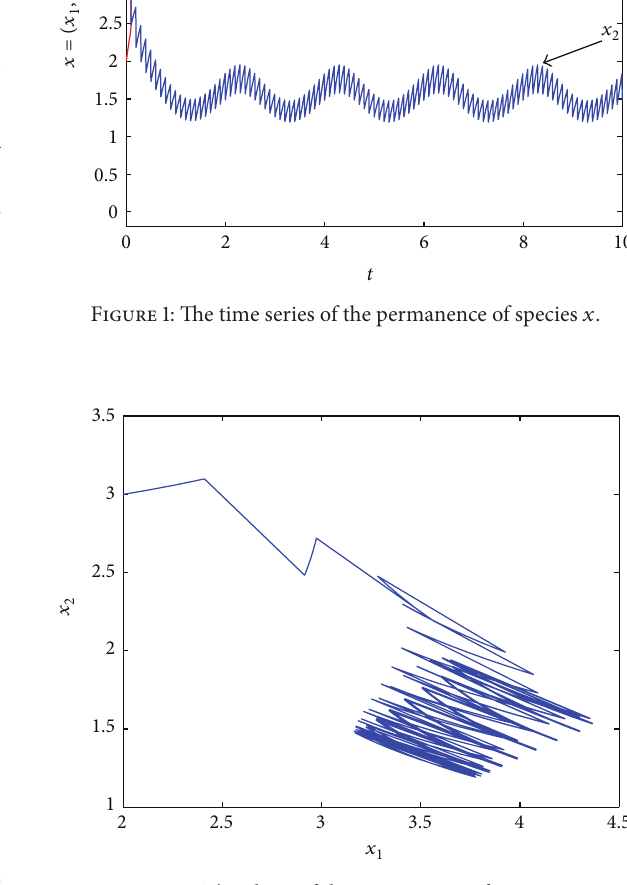
Figure 2: The phase of the permanence of species 𝑥